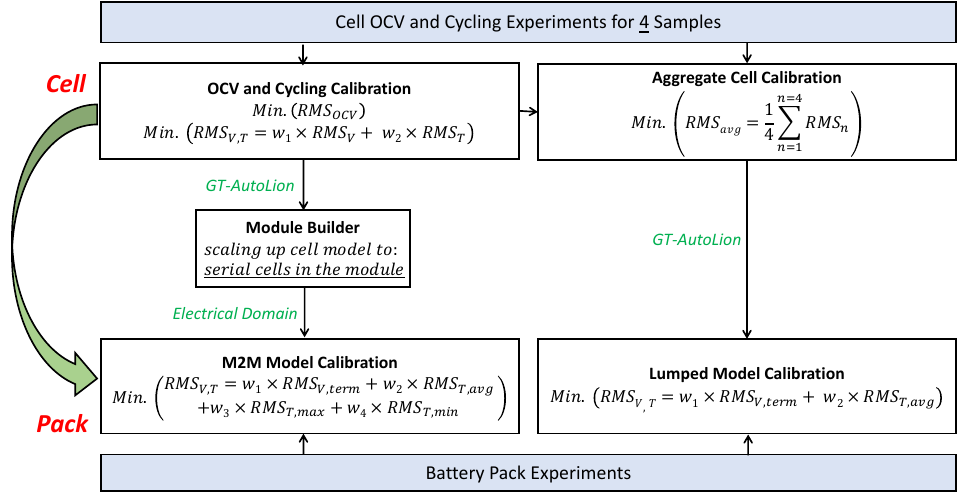
Figure 3. Li-ion battery cell and battery pack calibration optimization